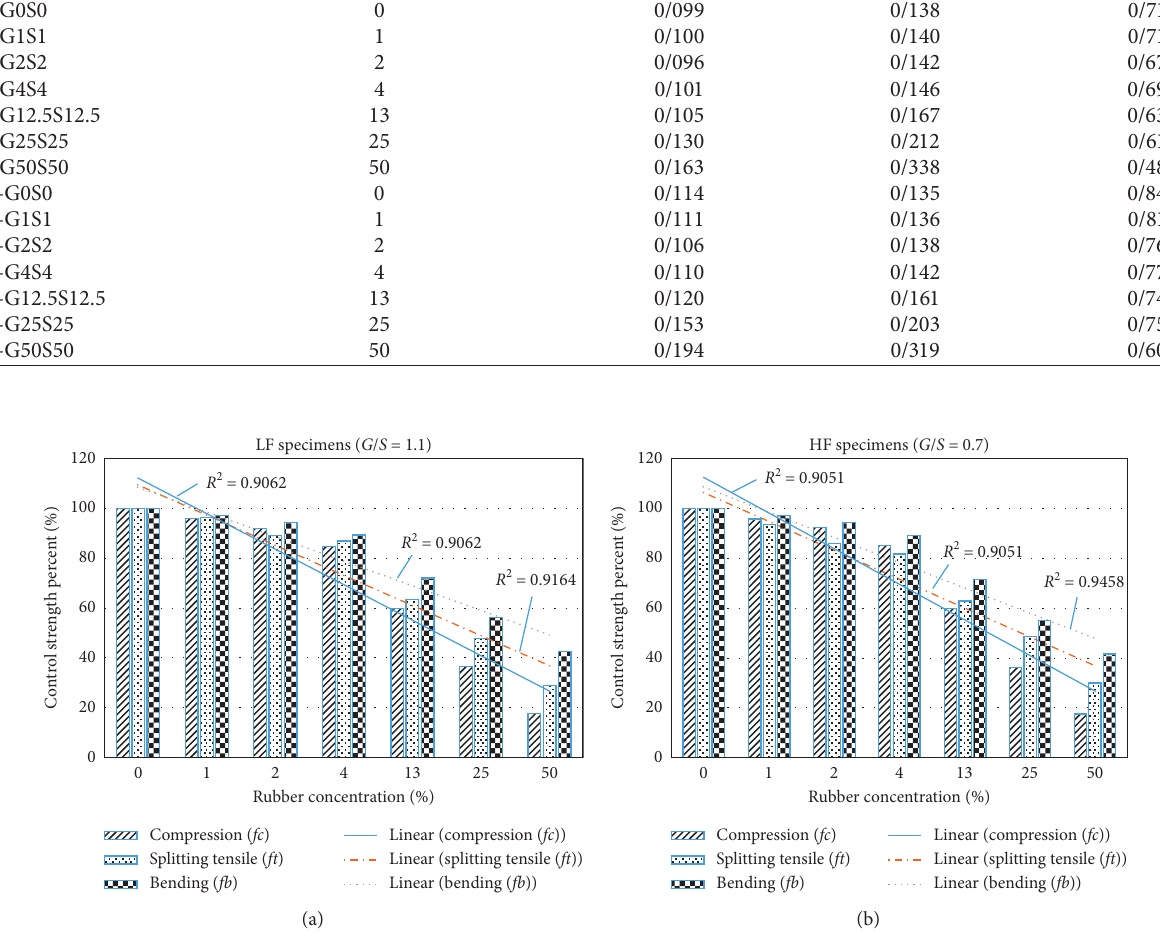
Table 6: Comparison of strength ratios based on the silicone rubber content. Concrete